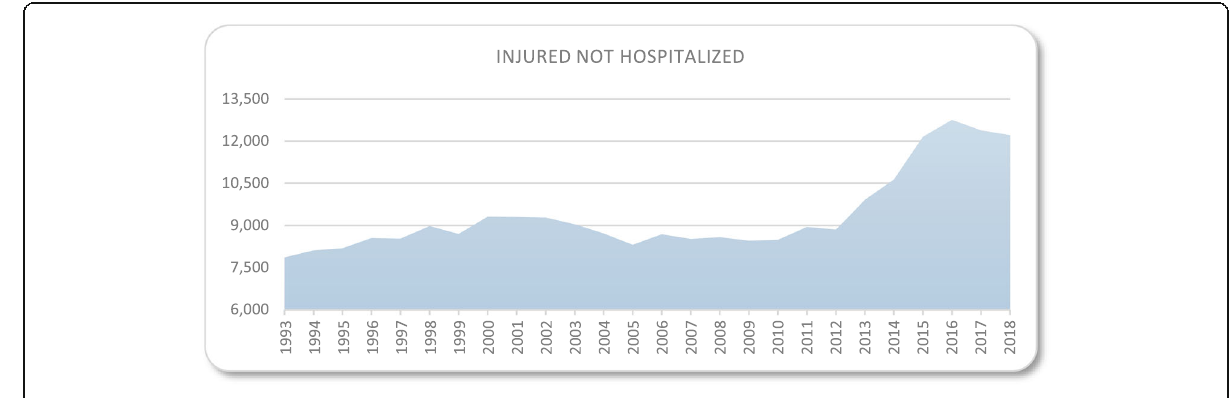
Fig. 16 The Number of injured not hospitalized in Spain (2018 data)